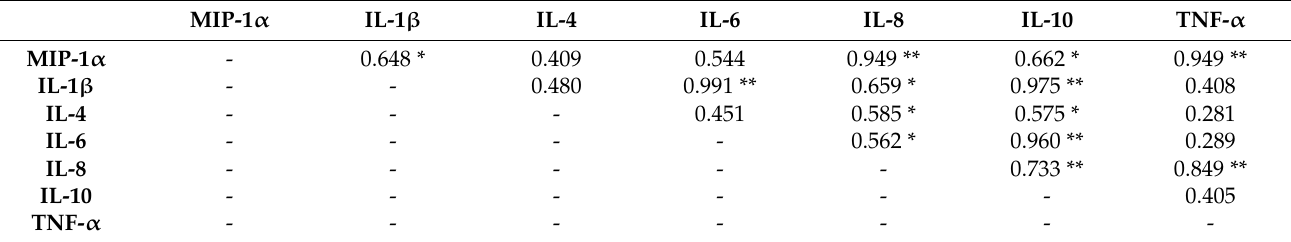
Table 4. The correlation coefficient r between serum values of cytokines before treatment.